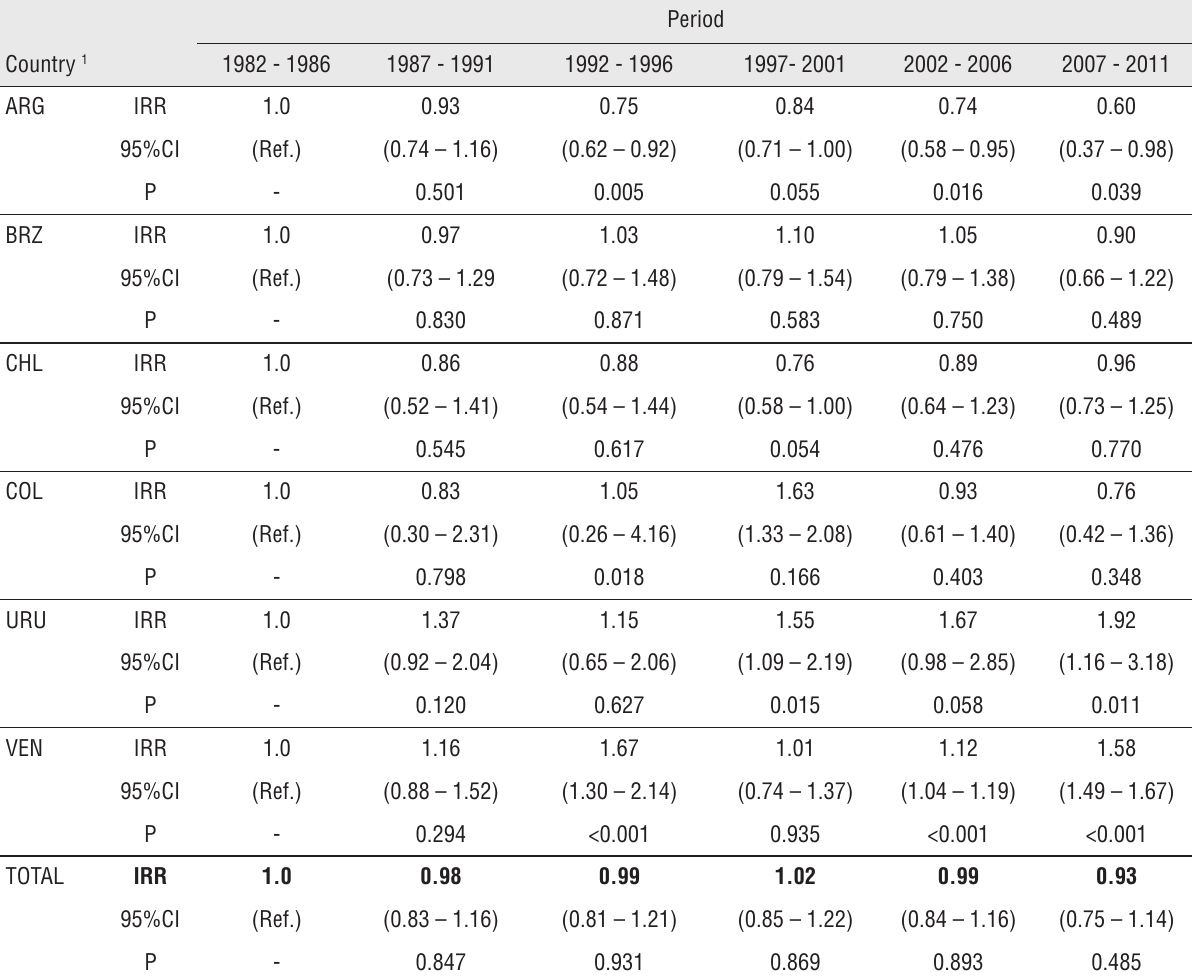
Table 3 - Results from adjusted regression models evaluating temporal changes in the prevalence of total hypospadias from 1982 to 2011 in six countries of South